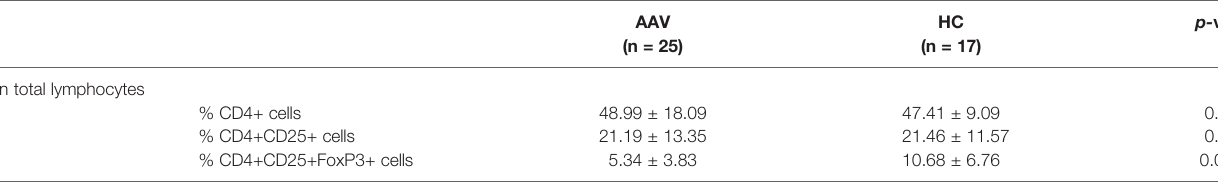
TABLE 1 | Frequency of CD4+CD25+FoxP3+ cells in patients with AAV and healthy controls.